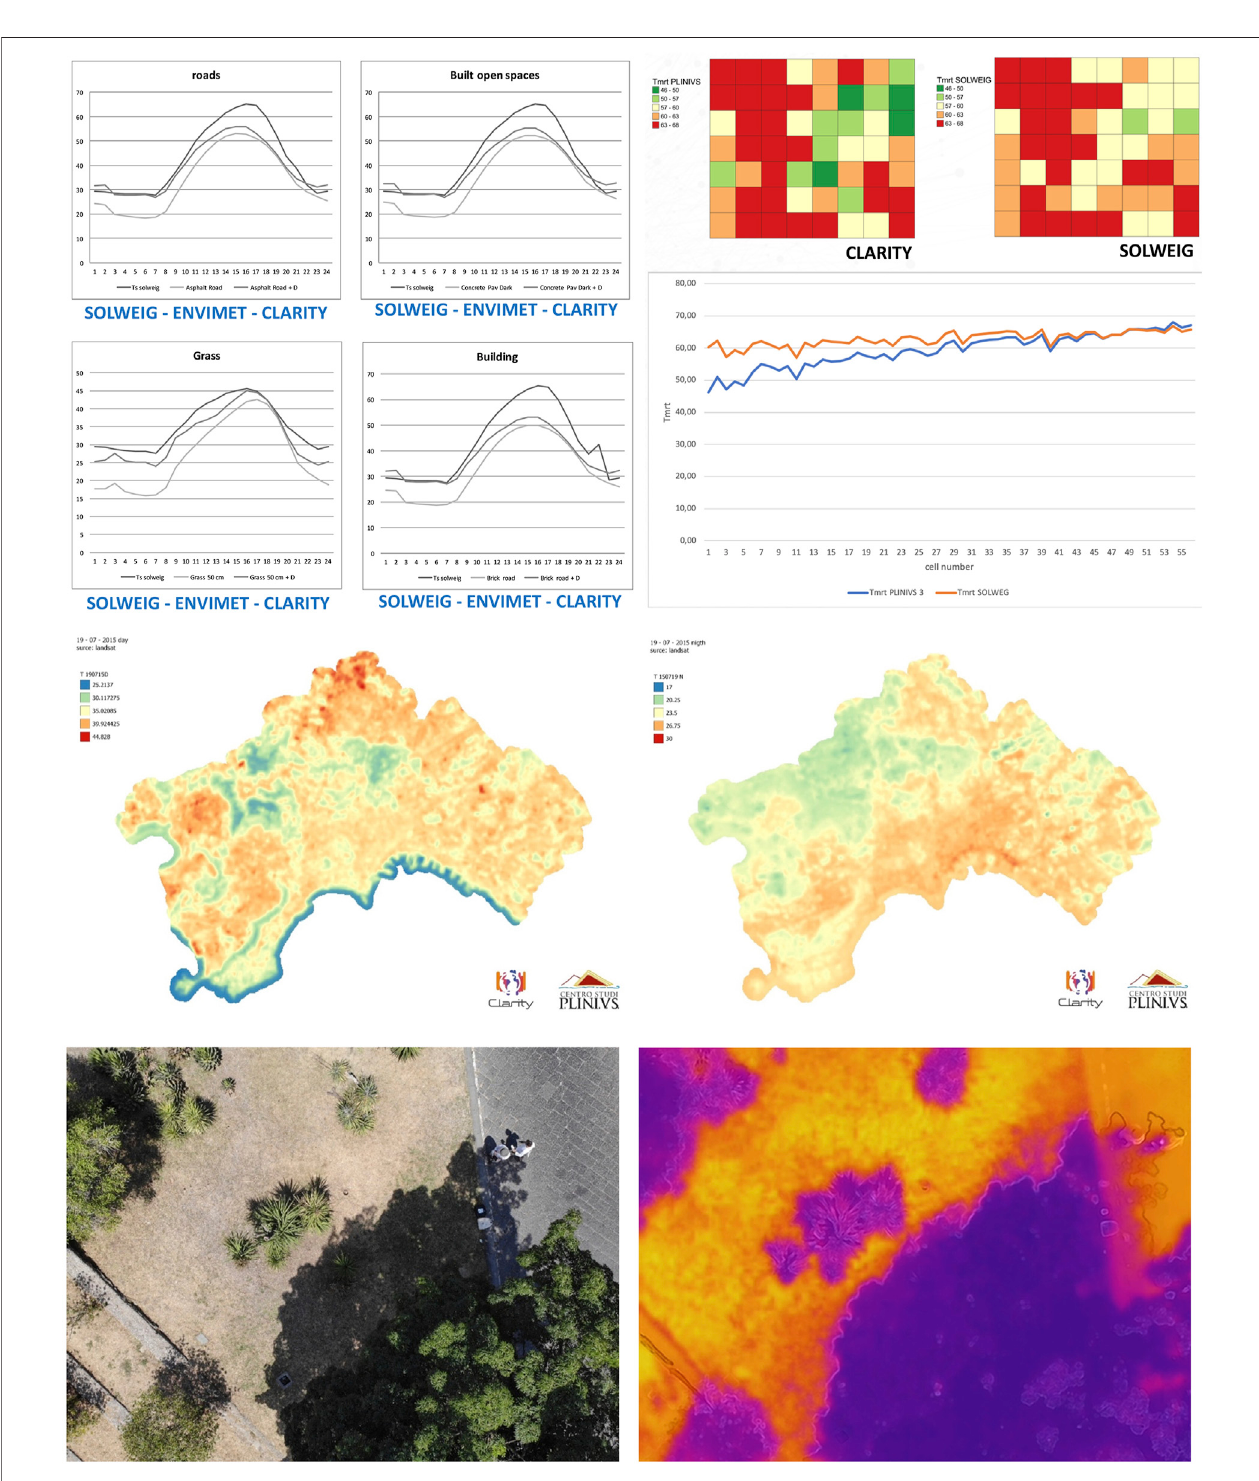
FIGURE 2 | Calibration of surface temperature and mean radiant temperature values in the HWLEM: comparison with results from ENVI-MET and SOLWEIG models (top) ; observed land surface temperature data from Landsat, July 19, 2015 (center) and from drone campaign, July 30, 2020 (bottom) .